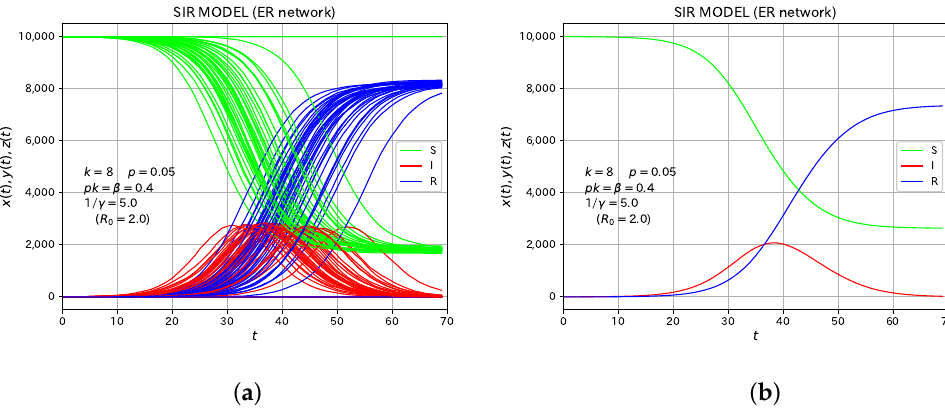
Figure 7. The simulational results of the microscopic SIR model on the ER network. Only a single individual is infected at t = 0. Initial values are x ( 0 ) = 9999, y ( 0 ) = 1, and z ( 0 ) = 0. ( a ) All the results of 40 samples are plotted; ( b ) the average over 40